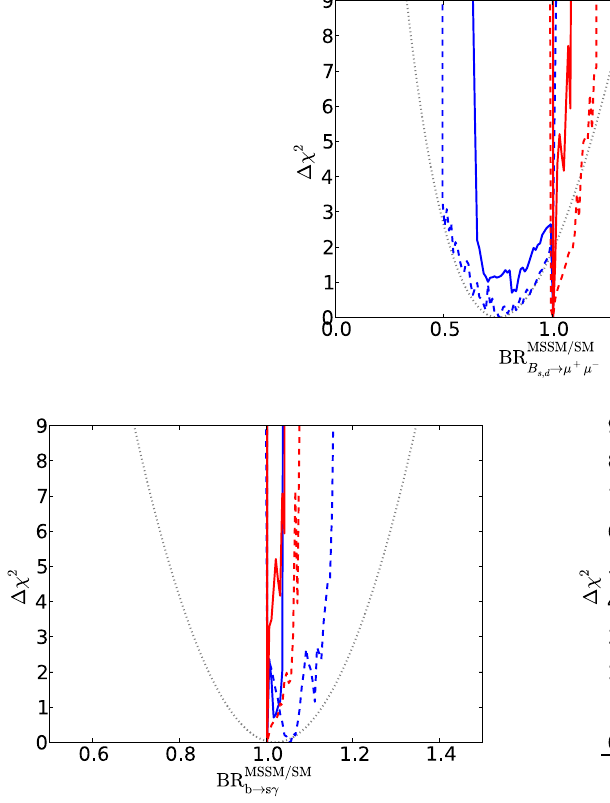
Fig. 19 The χ 2 likelihood functions for the ratios of BR ( B s , d → μ + μ − ) , BR ( b → s γ) to their SM values, and for the contribution to ( g − 2 ) μ /2. We show curves with both (cid:4) ˜ χ 0